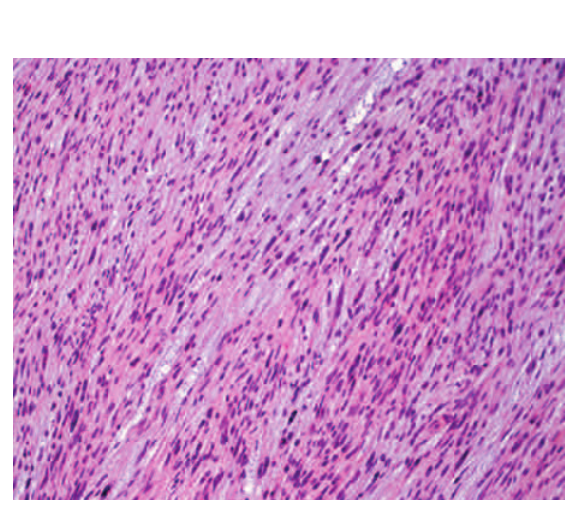
Figure 4. Photomicrograph of the tumor. The tumor is composed of spindle cells ( hematoxylin and eosin, x 200) (Fig.4) with positive immunohistochemistry staining for